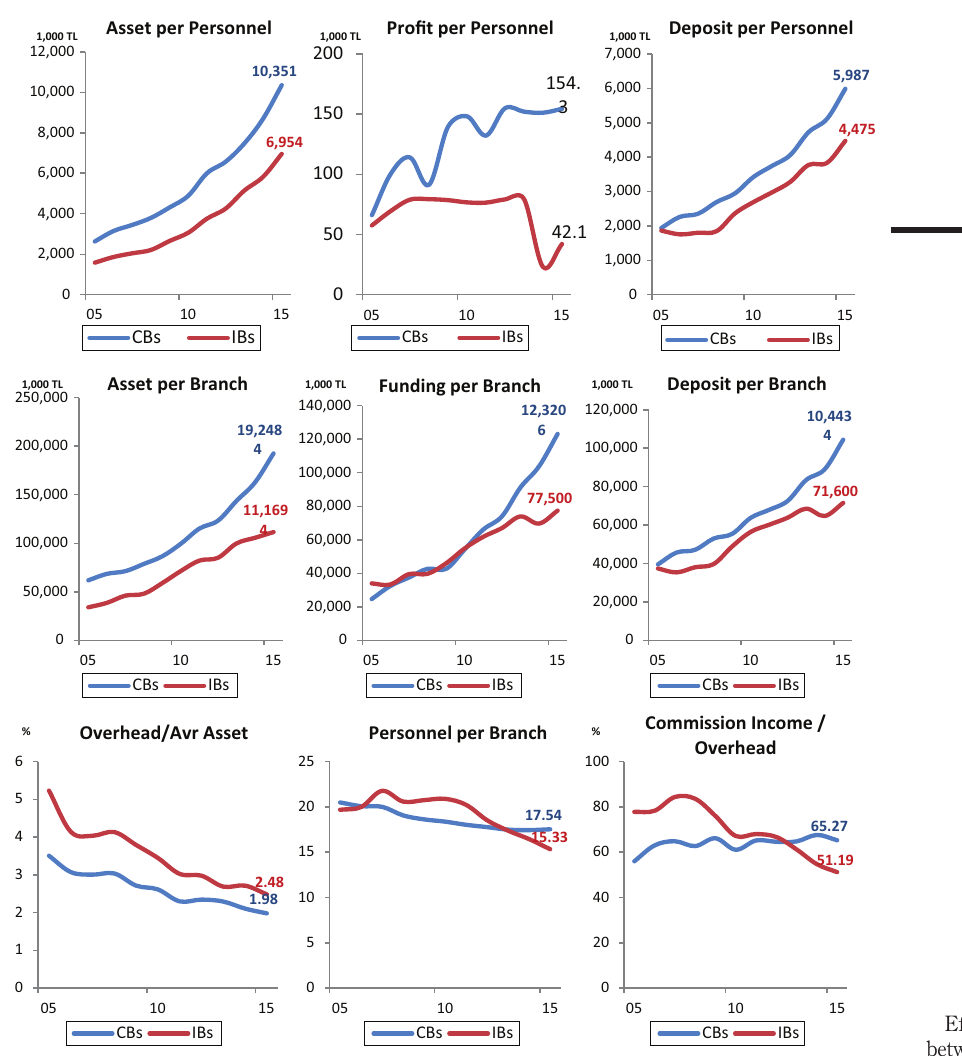
Figure 8. Ef fi ciency KPIs between 2005 and